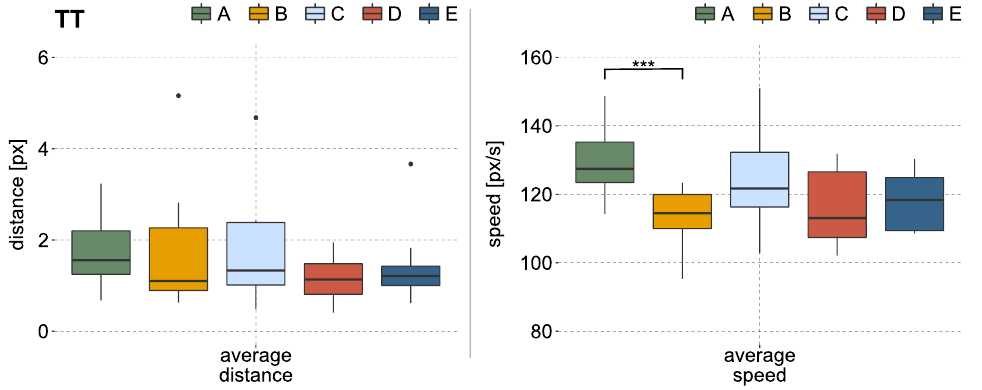
Figure 7. Results of the TT over all subjects, based on the mean values of each subject per labeling method. ( Left ): boxplot of the average distance from cursor to target. The total distance traveled per trial was 1600px. There was no significant effect between the methods. ( Right ): boxplot of the average travel speed of the cursor. The target moved with a constant velocity of 100px/s. A significant effect was identified between method A and B by the KW test and the post hoc